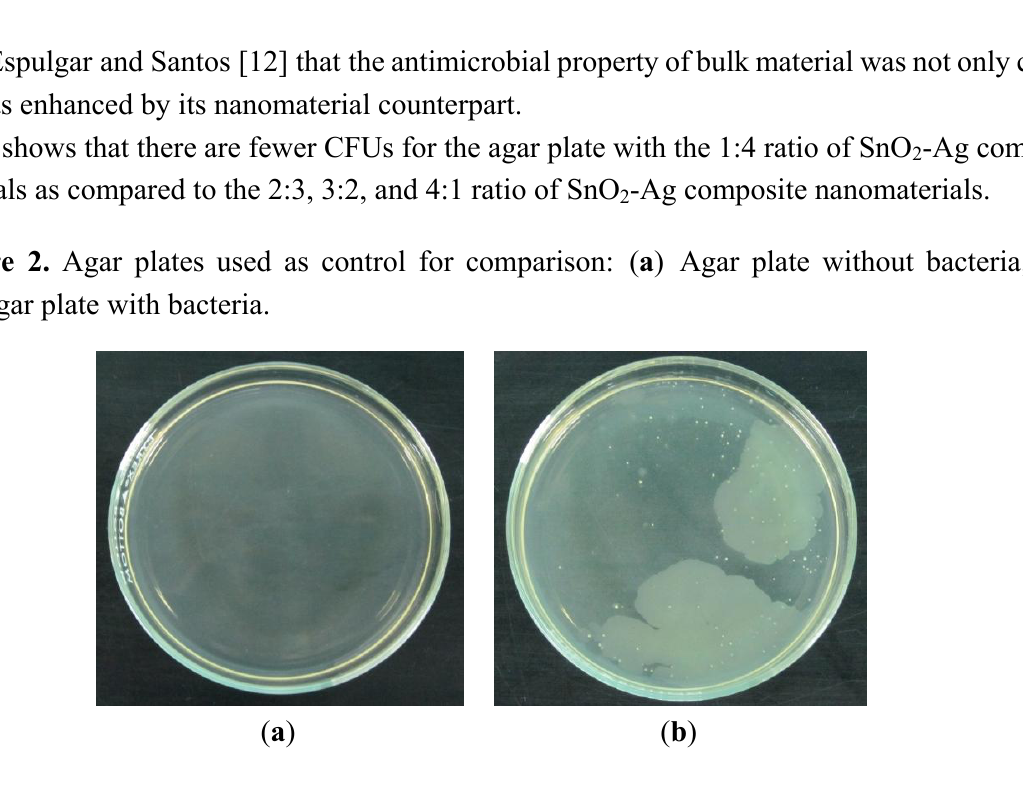
Figure 3. Comparison on colony forming units (CFU) between ( a , c ) powder and ( b , d ) nanomaterial on ( a , b ) Ag and ( c , d ) SnO 2